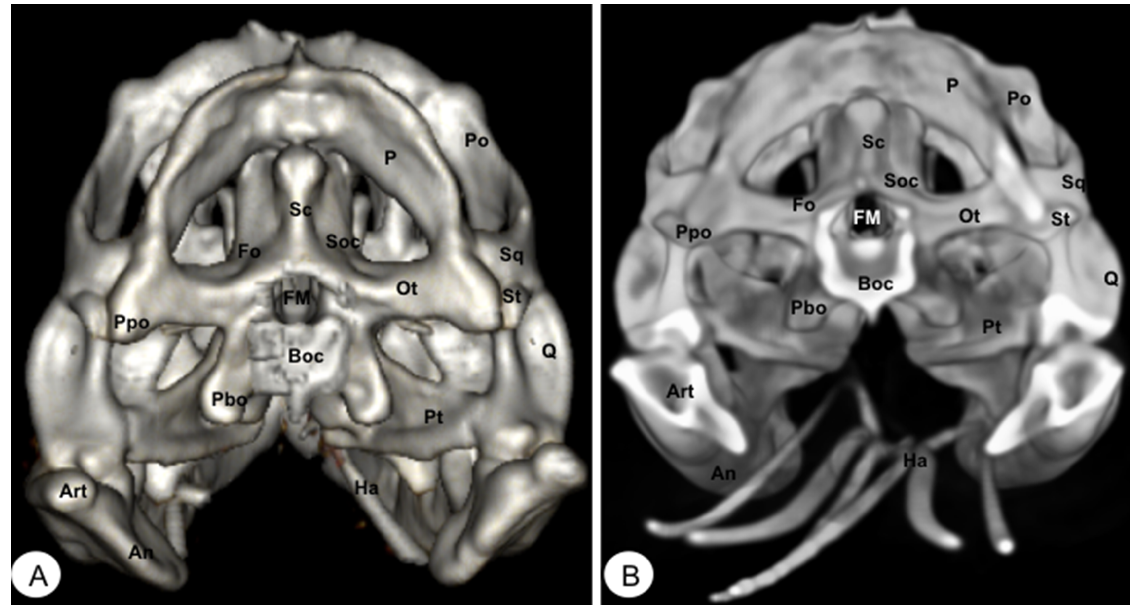
Figure 11. Head of Iguana iguana . ( A ) Caudal VR image without hyoid apparatus. ( B ) Caudal MIP image. Sc: Occipital sagital crest. Soc: Supraoccipital. P: Parietal. Ot: Otoccipital. FM: Foramen magnum. Pt: Pterygoid. Po: Postorbital. Sq: Squamosal. St: Supratemporal. Boc: Basioccipital. Ppo: Paroccipital process. Pbo: Parabasioccipital process. Fo: Otoccipital facet. An: Angular. Art: Articular. Ha: Hyoid apparatus.